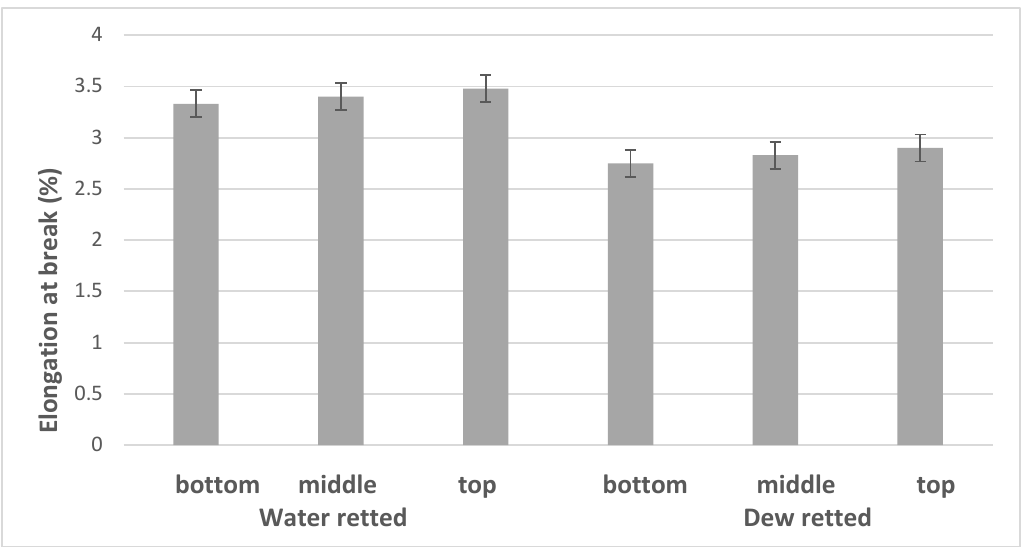
Figure 6. Effect of plant section used for fiber extraction and the retting method on fiber elongation at break rates (%) (Error bars represent standard errors).